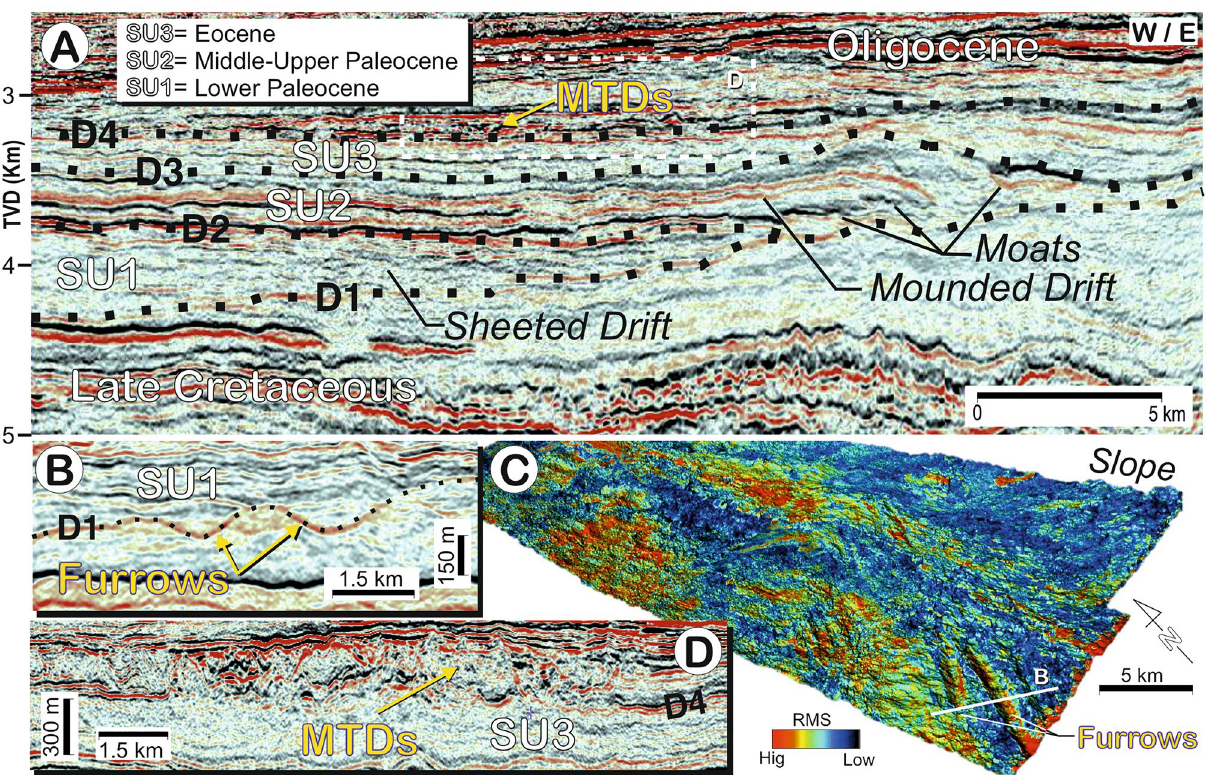
Figure 2. ( A ) 3D seismic lines indicating the seismic units, discontinuities and their chronology. ( B ) Furrows identified at basal discontinuity D1 with seismic lines, ( C ) the root mean square (RMS) amplitude attribute extraction for surface D1. ( D ) Example of the Mass Transport Deposits (MTDs) over discontinuity D4. Seismic line location in Fig.